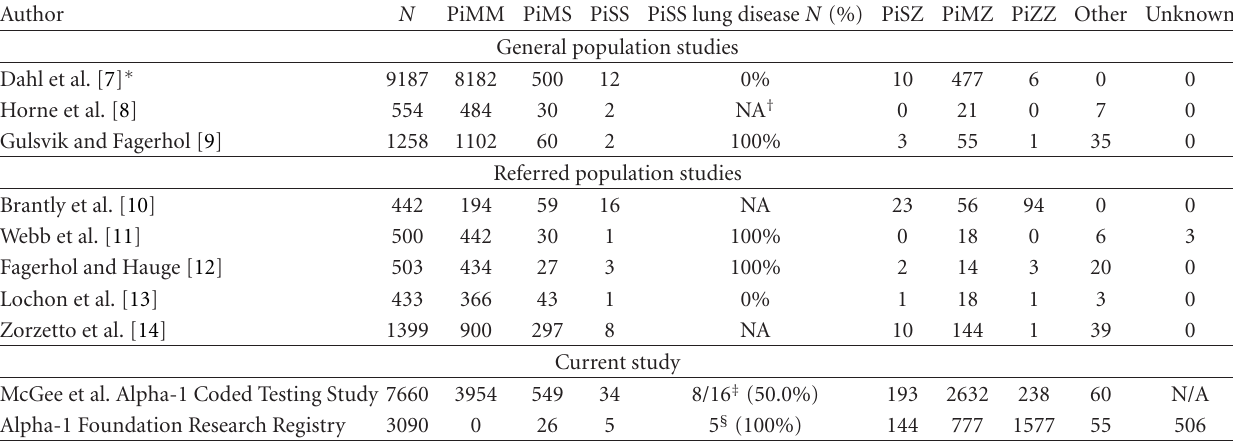
Table 1: Published research on Alpha-1 antitrypsin population genetics when PiSS was reported.